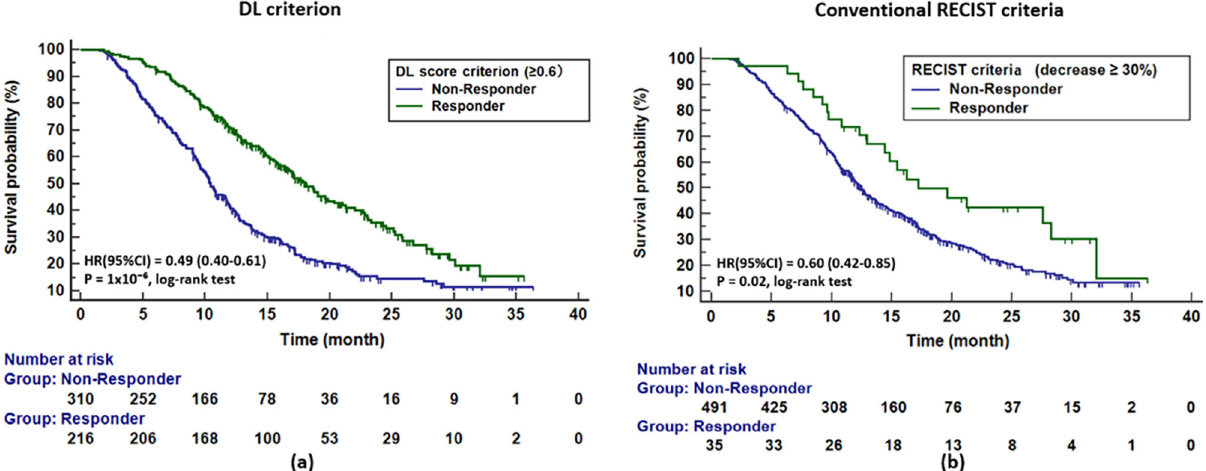
Fig. 3 Survival analysis on DL score criterion and conventional RECIST criteria. Plots of Kaplan-Meier estimator as well as hazard ratios and p -values estimated via log-rank test are present. For ( a ) DL score criterion, the responders are de fi ned as score ≥ 0.6 and ( b ) for the conventional RECIST criteria, the responders are de fi ned as tumor burden decreasing 30% or more. Table 3 Seven different prognostic models for early prediction of OS in patients with mCRC.